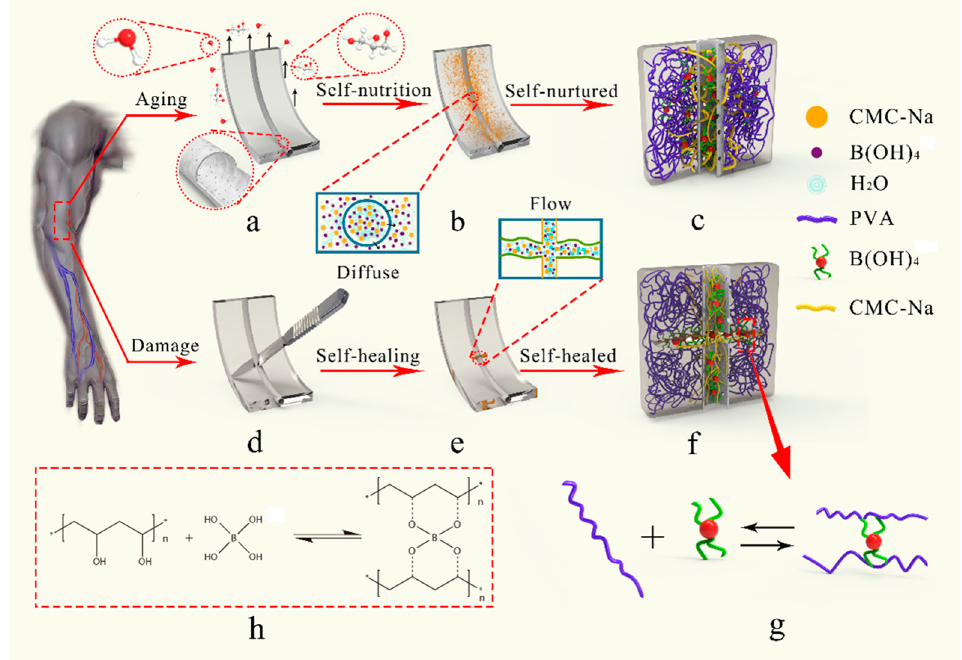
Figure 1. Illustration of the self-nourishing and self-healing function of artificial skin by bionic microvascular. ( a ) The artificial skin’s aging process, volatilize by water and glycerin. The shell of the bionic microvascular has a microporous structure. ( b ) The healing agent released by the microporous structure to achieve self-nourishing function. ( c ) Illustration of the molecular structure of self-nourishing. ( d ) The artificial skin is damaged and wounds appear. ( e ) The healing agent poured by the wounds to achieve self-healing function. ( f ) Illustration of the molecular structure of self-healing. ( g , h ) Illustration of the chemical reaction of self-nourishing and self-healing.